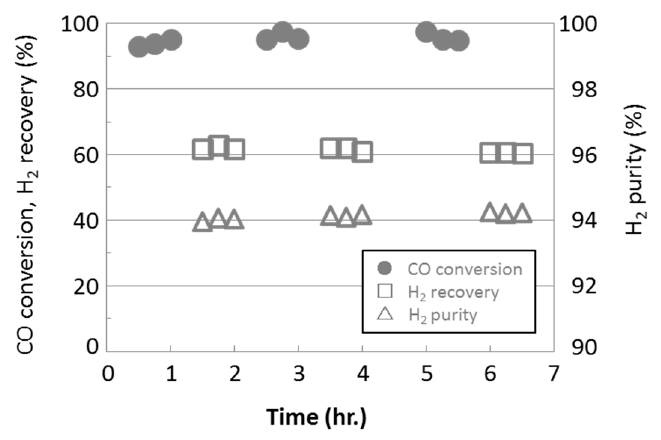
Figure 11. Water gas shift reaction by membrane reactor installed the developed HMDSO-derived silica membrane.